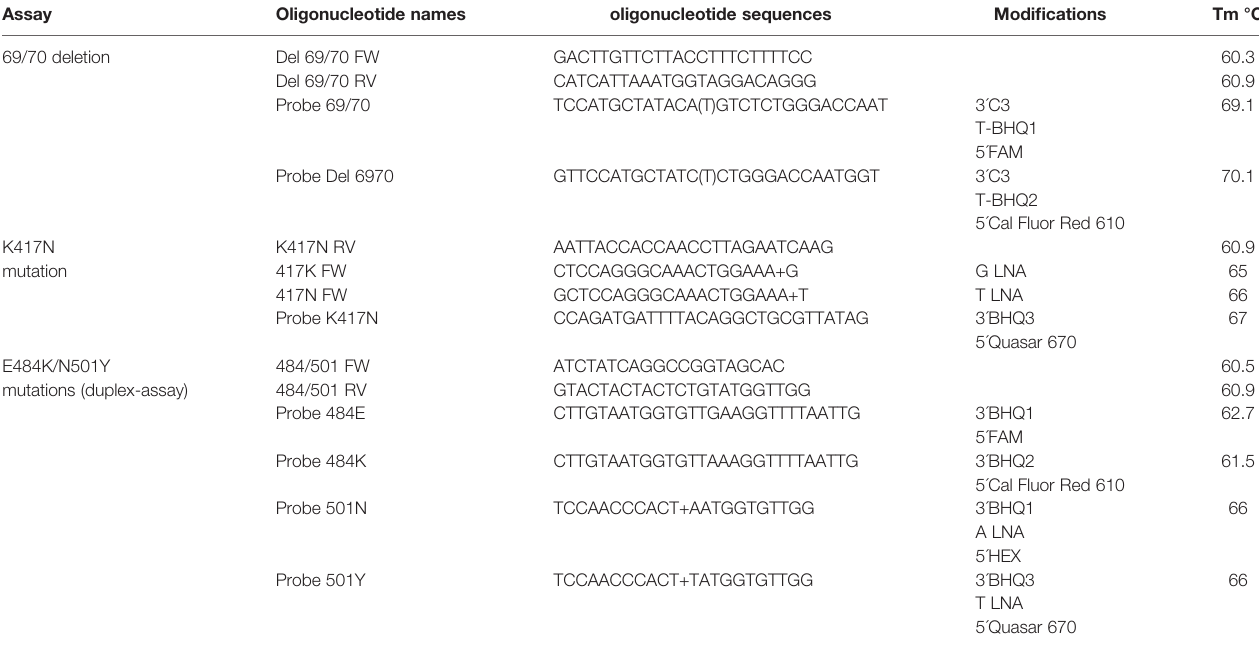
The letter “ T ” in parentheses denotes the position of the internal quencher. The symbol “ + ” indicates that the next base is a modi fi ed base